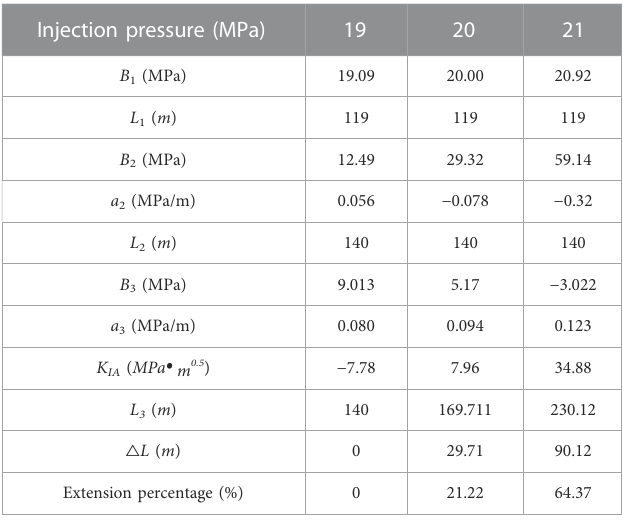
TABLE 2 Parameters and calculation results for the three cases with different injection